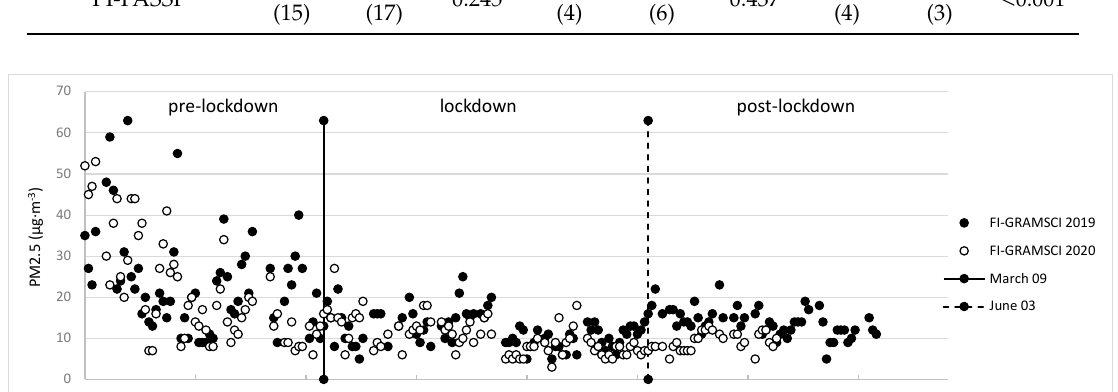
Table 3. Output of the two-sample t-test to evaluate the lockdown effects on PM2.5 air concentration. The PM2.5 values are expressed in μ g ∙ m -3 . Figure 2. The daily mean concentration of PM10 ( μ g ∙ m − 3 ). In each graph, the lockdown period is depicted between the two vertical bars.